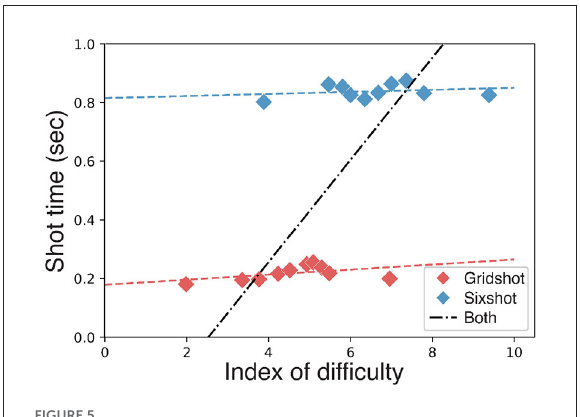
FIGURE5 Fitts Law. Shot time as a function of target distance. Index of difficulty: log 2 (2 d / e ) where d is target distance and e is shot error. Blue line, regression line fit to Sixshot data. Red line, regression line fit to Gridshot data. Black line, failure to fit data from both tasks